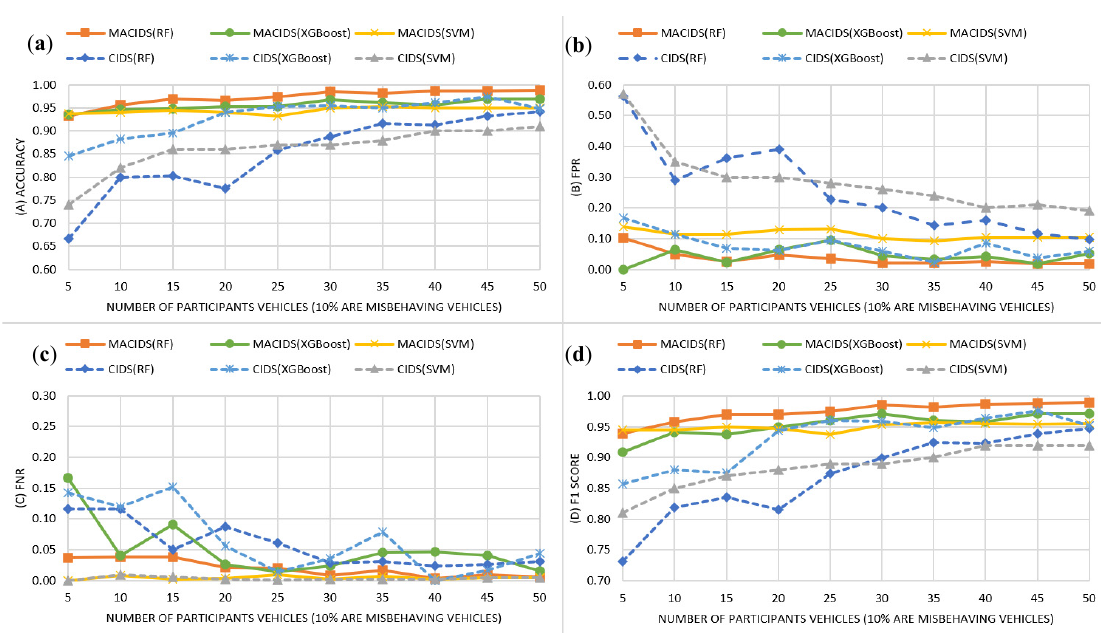
Figure 4. Impact of number of collaborators on the detection performance in terms of ( a ) Accuracy, ( b ) False Positive Rate, ( c ) False Negative Rate, and ( d ) F1 Score.